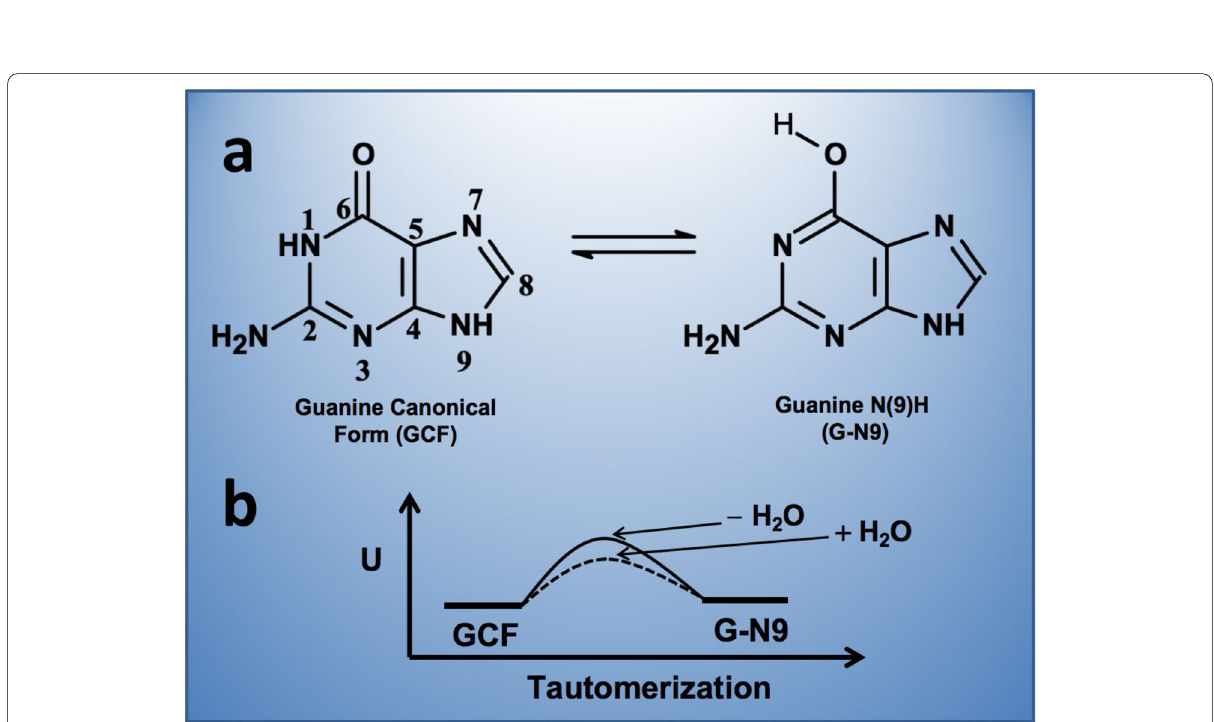
Fig. 5 Guanine canonical and N(9)H tautomers. Solvation significantly lowers the tautomerization energy barrier to interconvert the canonical form into a N(9)H tautomer. In the absence of water, this barrier increases and tautomerization slows